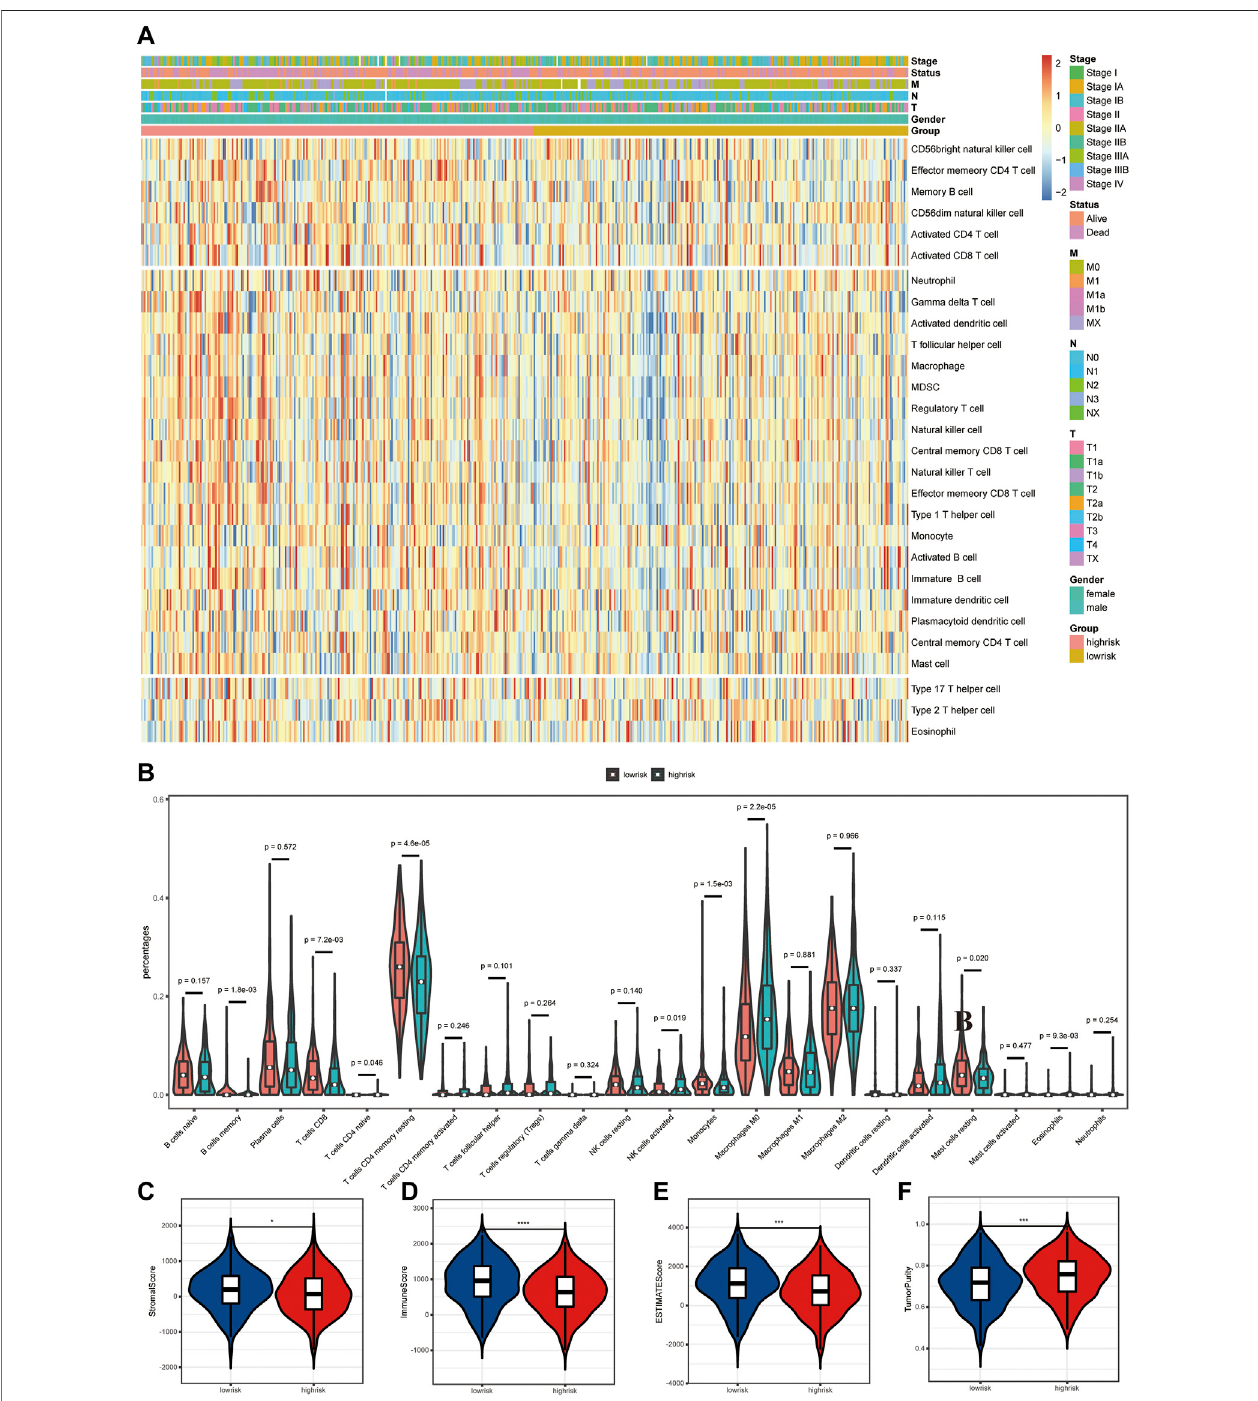
FIGURE 5 | Differences in tumor immune microenvironment (TME) between high- and low-risk LUAD patients. (A) Heatmap of 28 in fi ltrating immune cell levels between high and low risks with ssGSEA. (B) Comparisons of 22 important immune fractions between high and low risks with CIBERSORT. (C – F) Comparison of the ESTIMATE score, stromal score, immune score, and tumor purity between high and low risks with ESTIMATE.